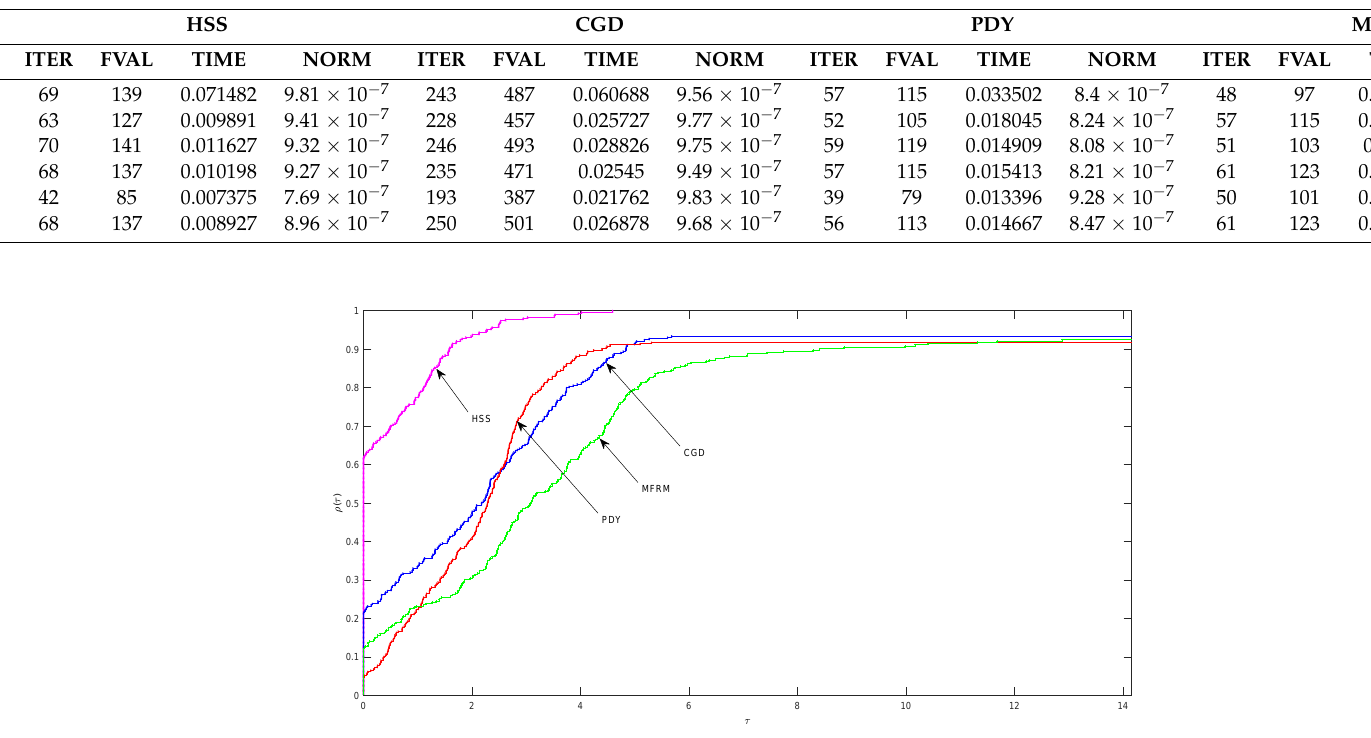
Figure 3. Dolan and Moré performance profile with respect to CPU